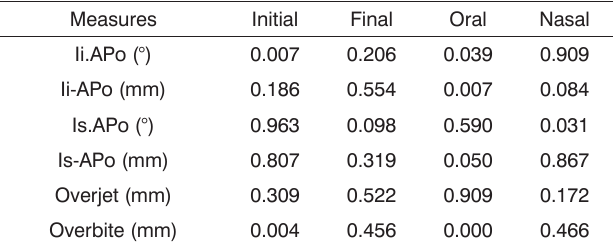
Table 2. p values obtained from the Student’s t-test and Wil- coxon intergroup for the initial and final values (Oral versus Nasal groups), and Oral and Nasal intergroup (initial versus final value).